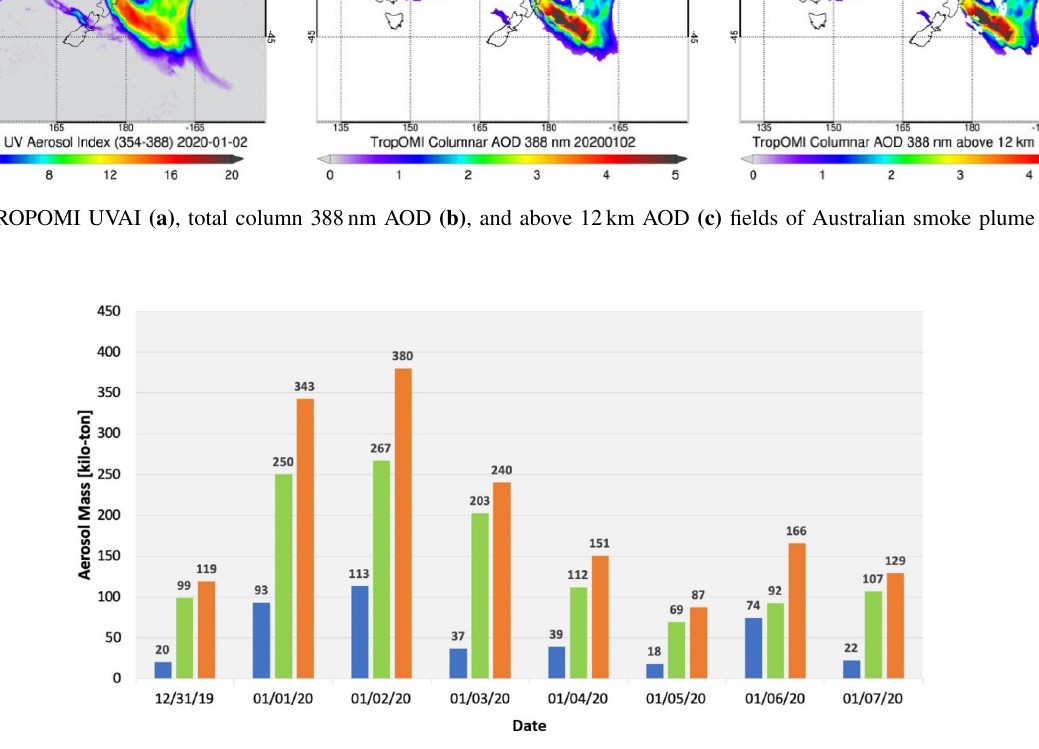
Figure 14. Calculated daily aerosol mass (kilotons) in the stratosphere from TROPOMI observations from 31 December 2019 to 7 Jan- uary 2020. Results are reported for aerosols in cloud-free conditions (blue bars), aerosol above cloudy scenes (green bars), and their sum (orange